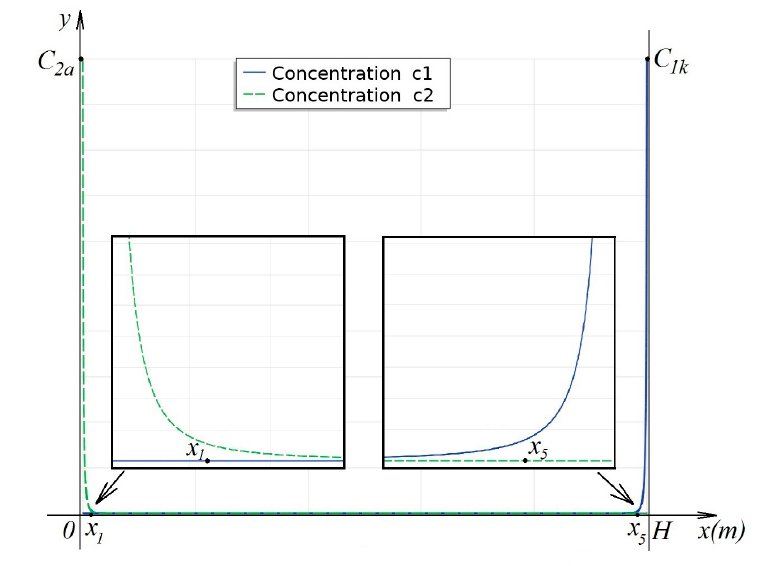
Figure 2. Distribution of concentration profiles K + and Cl − in the channel cross – section for the stationary case at j 1 = j 2 ≡ 0: x 1 and x 5 —boundaries of quasi-equilibrium space charge regions near anion-exchange membranes (AEM) and cation-exchange membranes (CEM), respectively. Between points x 1 and x 5 , the concentration value is